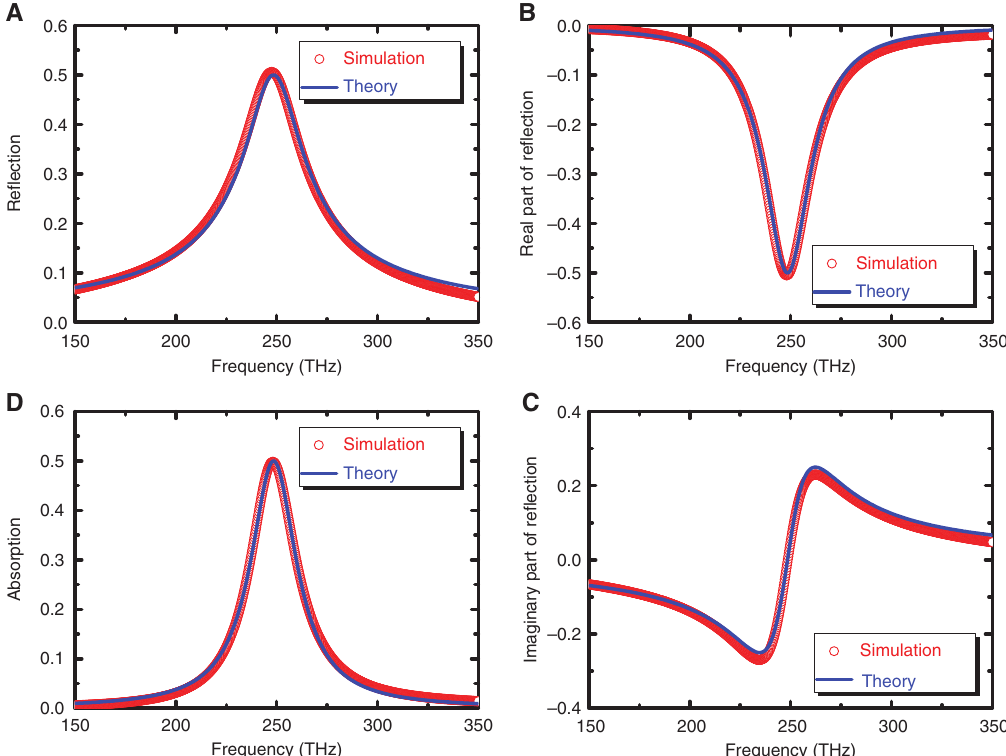
Figure 2: The change of reflection and absorption coefficients of a single bright metaatom with incident frequency. (A) Absolute value, (B) real and (C) imaginary parts of reflection coefficient, and (D) absorption coefficient. Blue line and red circle respectively denote theoretical and simulation results.